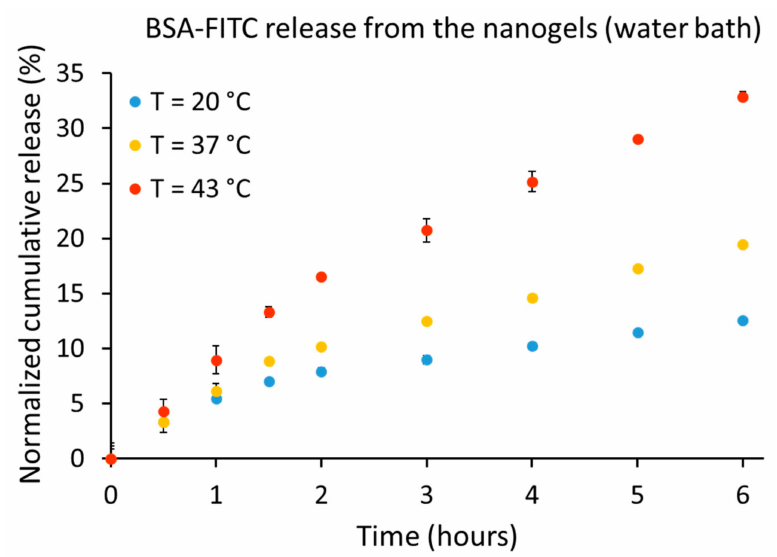
Figure 4. Bovine saline albumin labeled with fluorescein (BSA-FITC) release from the nanogels using a water bath as a heat source. After 6 h, 12.5%, 19.5%, and 32.8% of the BSA-FITC were released from the nanogels at 20 ◦ C, 37 ◦ C and 43 ◦ C, respectively. After 19 h, 14.1%, 27.6% and 43.6% of the BSA-FITC were released from the nanogels at 20 ◦ C, 37 ◦ C, and 43 ◦ C, respectively.